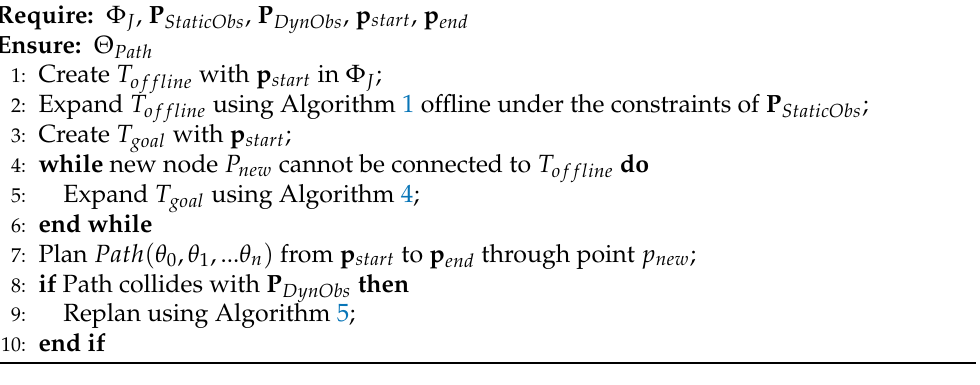
Algorithm 3 Motion planning for the live-line maintenance robot.